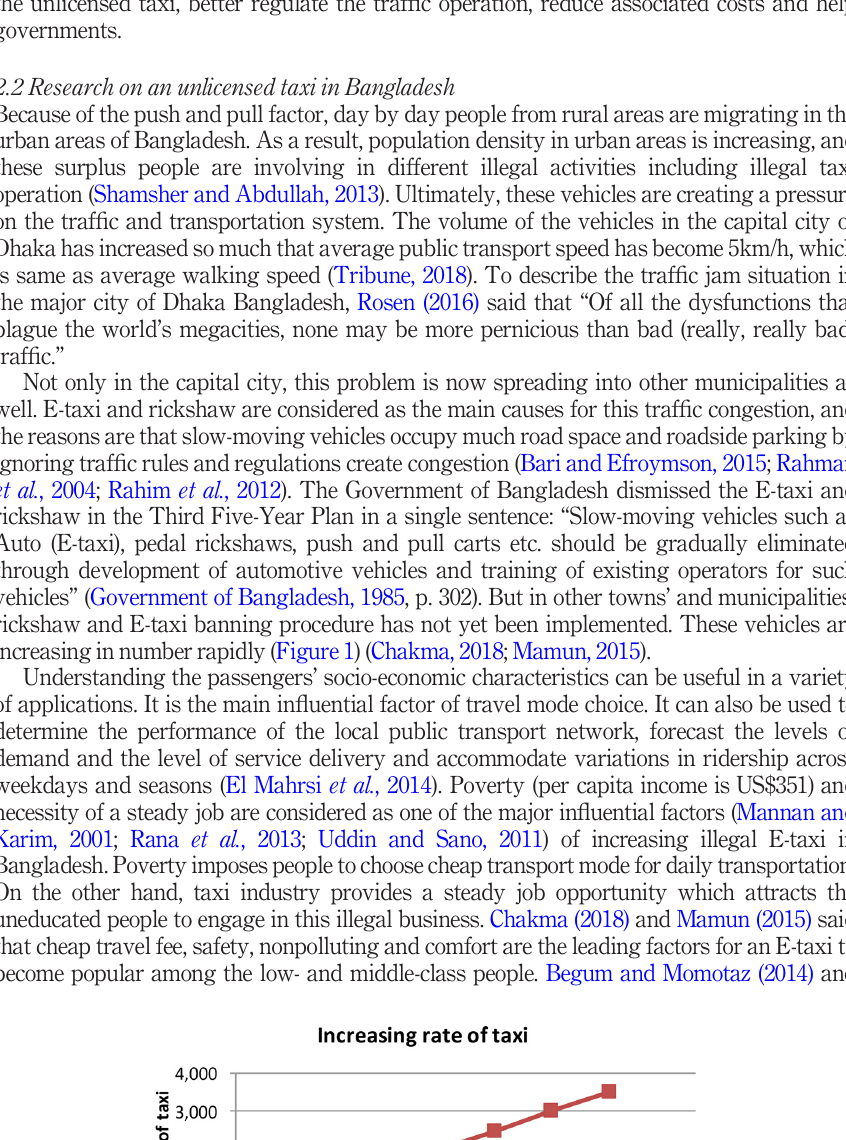
Figure 1. Increasing rate